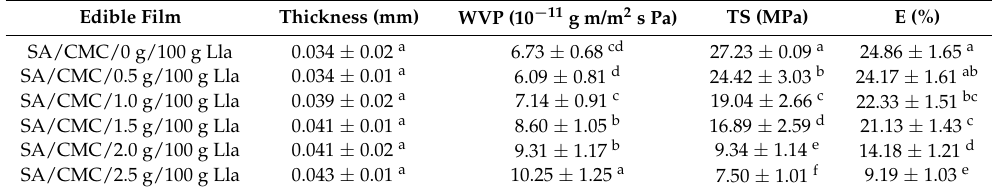
Figure 2. ( a ) Scanning electron microscope (SEM) micrographs of the films added with different concentrations (g/100 g) of Lactococcus lactis ; ( b ) SEM of the cross-section of the films added with 1.5 g/100 g Lactococcus lactis ; ( c ) SEM of the cross-section of the films added with 0 g/100 g Lactococcus lactis . Table 1. Effect of the incorporation Lactococcus lactis on thickness, water vapor permeability (WVP), and mechanical properties .